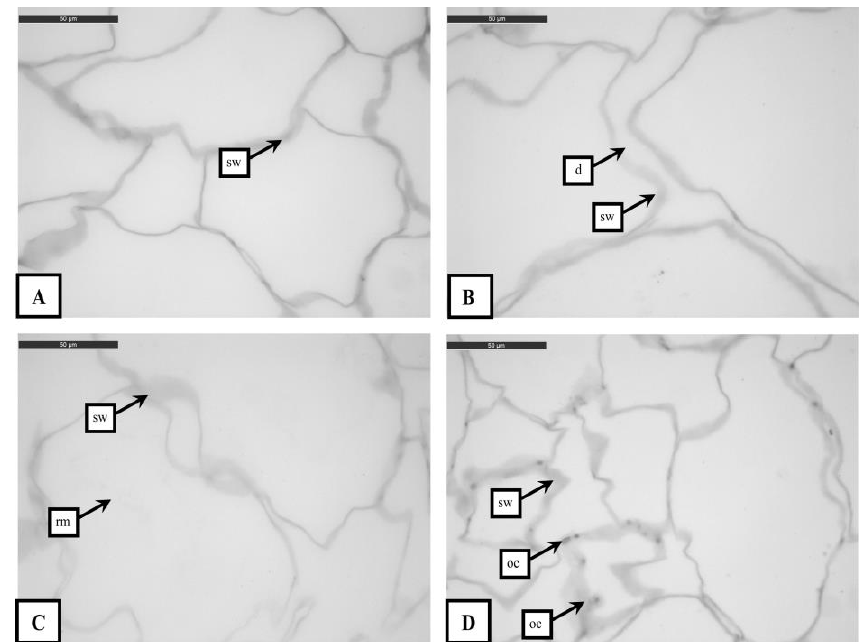
Figure 1. Transverse sections of peach samples subjected to different treatments and stained with Toluidine Blue: ( A ) ohm ; ( B ) ohm -DIM; ( C ) ohm -HPP; ( D ) ohm -OHM. Legend: sw: swelling; d: cells detachment; rm: rupture of the cellular membrane; oc: opened channels in the cell wall. For ohm samples ( A ) thickening of the cell walls was visible due to the swelling phenomenon (sw). For ohm -DIM samples ( B ), cell swelling (sw) and detachment (d) were visible. On ohm -HPP samples ( C ), rupture of the membrane structure (spots inside of the cells—rm) and thickening of the cell wall due to swelling (sw) were observed. For ohm -OHM samples ( D ), cell walls showed thickened sections alternated with thin sections (oc) with consequent formation of channels; also in this case thickening of the cell walls (swelling) was observed.